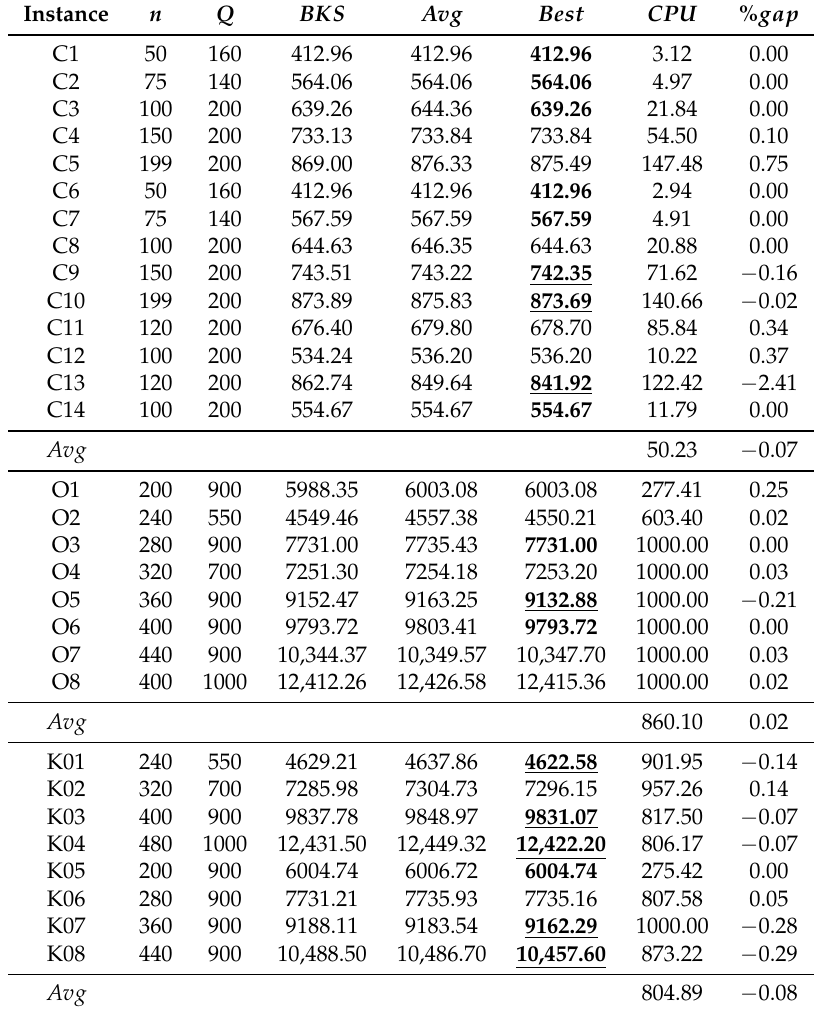
Table 6. Results obtained by the HGOALS for all the test instances (minimizing traveling